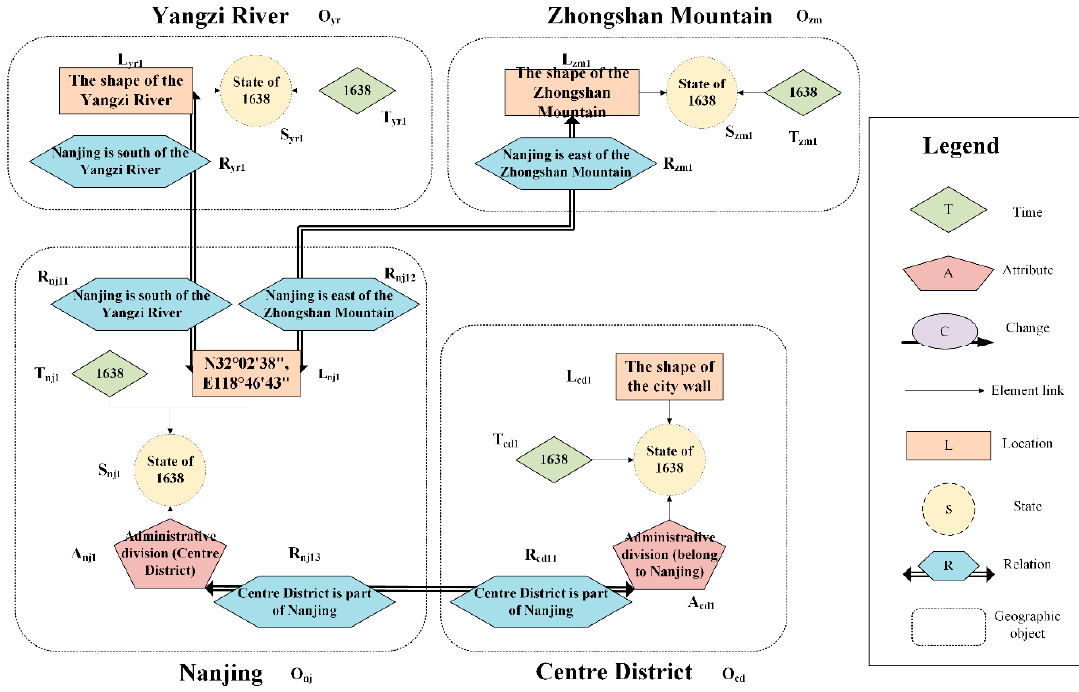
Figure 6. The diagram of relation elements of Nanjing in 1368.